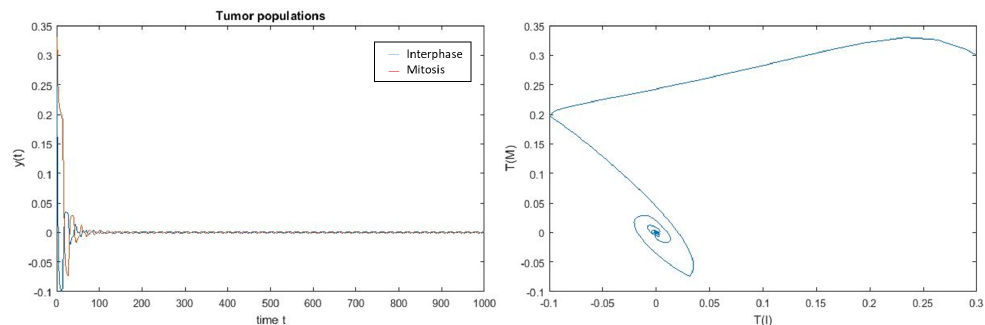
Figure 6. Tumour population with two immune response when τ = 12.9817 at E 0 = ( 0,0,15,0 )